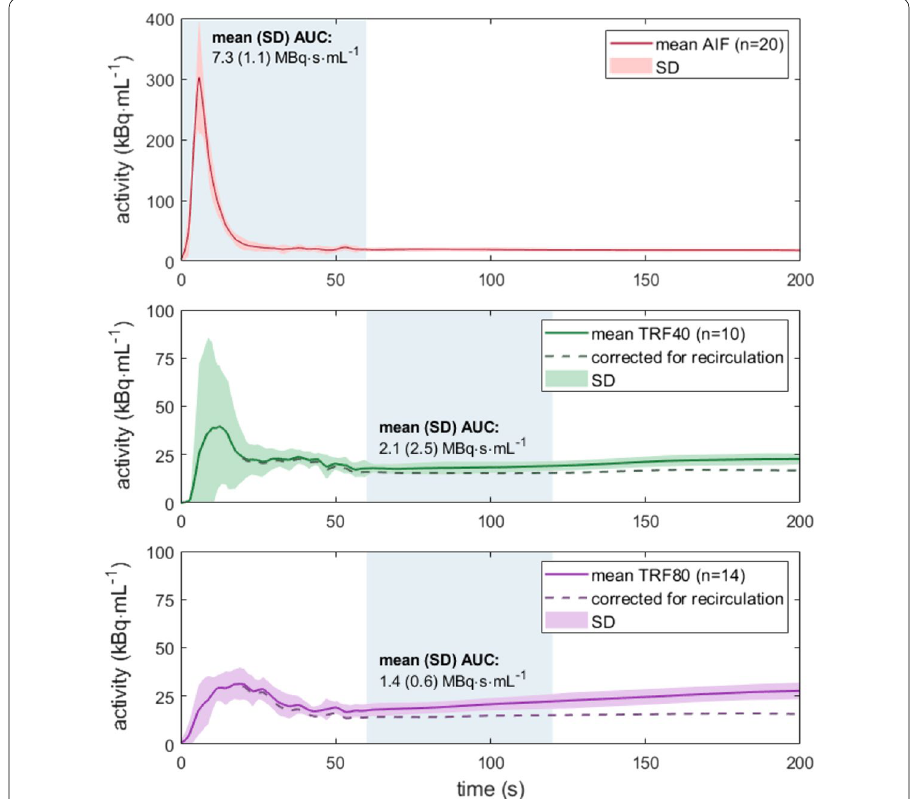
Fig. 5 Time activity curves derived from phantom measurements. The mean arterial input function (AIF) and tissue functions (TRFs) of n measurements were plotted together with their standard deviation (SD). TRF analysis distinguished between myocardial segment flow settings of 40 and 80 mL/min. The AUCs within the indicated blue regions served as input for myocardial blood flow estimation. The dashed lines in the TRFs suggest how the curves would look when corrected for radiotracer